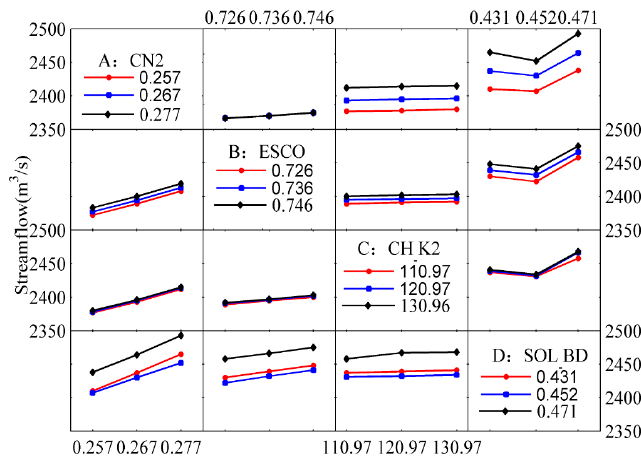
Figure 11. Interaction effects of parameters in the flood period.